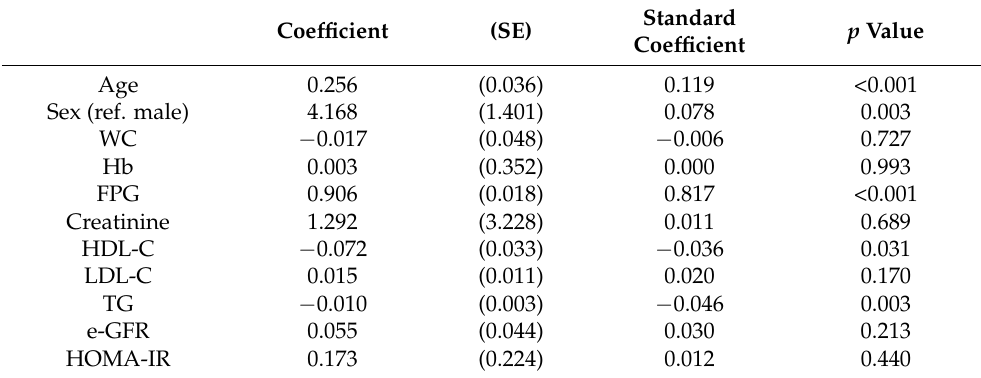
Table 4. Factors associated with eAG in the study